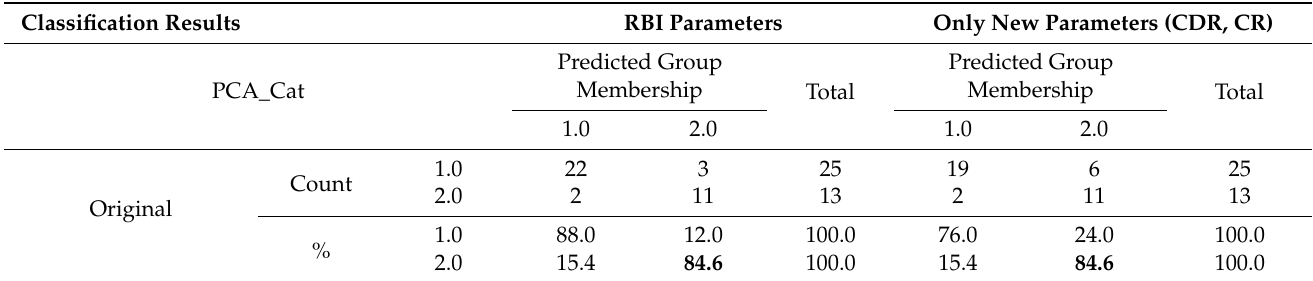
Table A12. Classification Summary—Comparison.